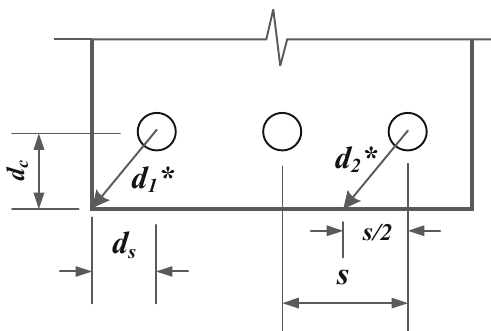
Fig. 3 Maximum distance from the outermost reinforcement centroid to the surface in the tension